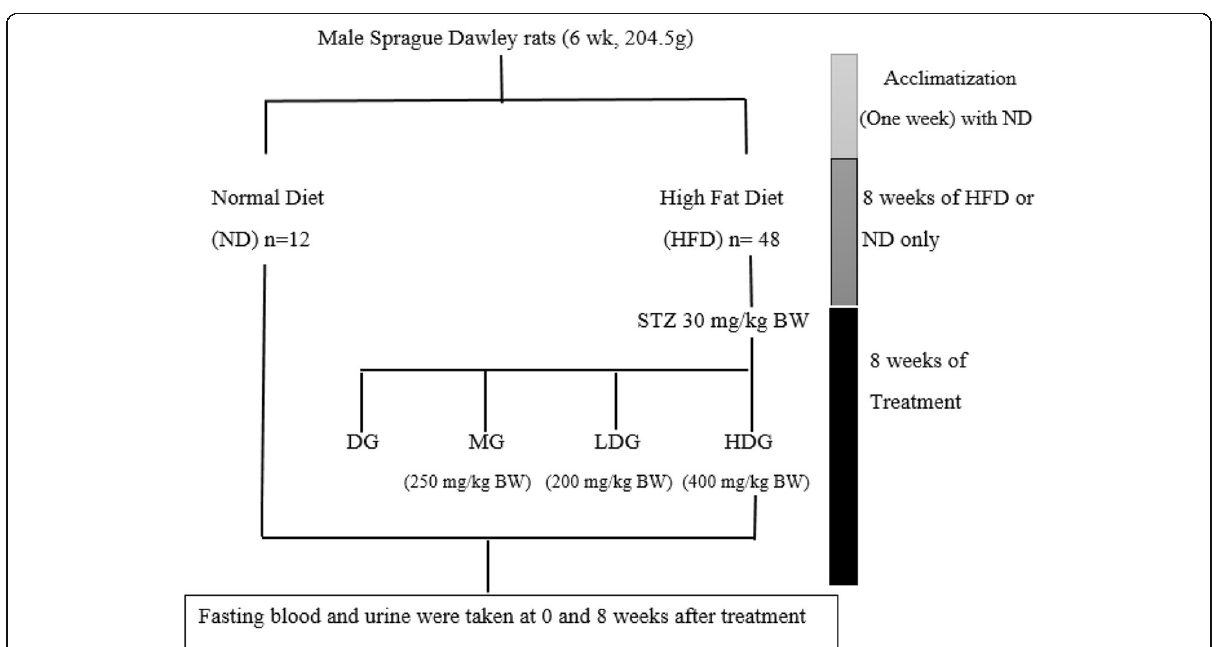
Fig. 1 Schematic diagram of the experimental design to evaluate the antidiabetic effect of 60% ethanolic of ML leaf extract in obese diabetic male Sprague-Dawley